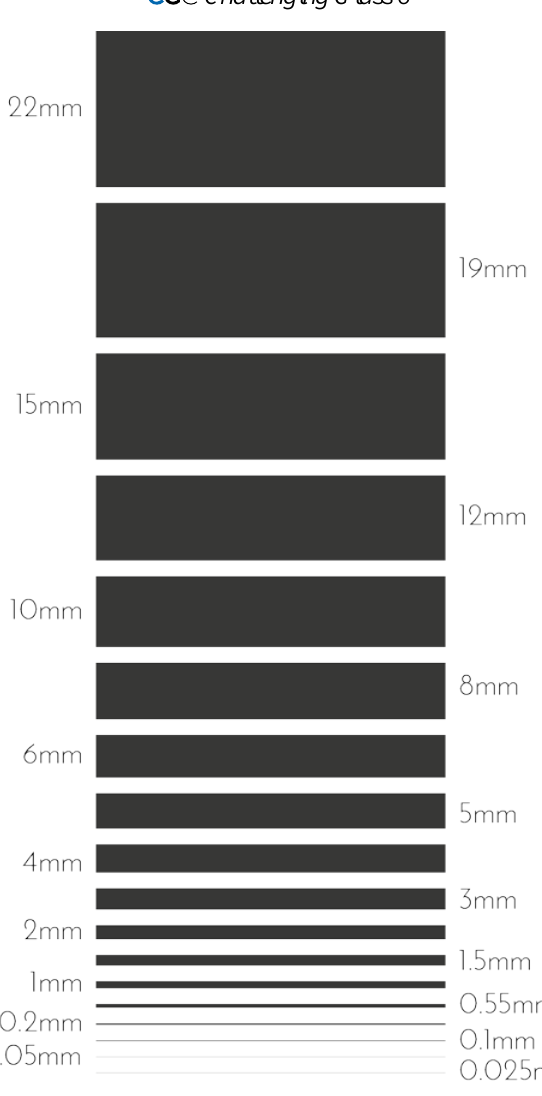
Fig. 1 Glass thicknesses at 1:1 scale - from 22mm to